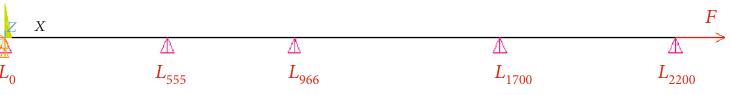
Figure 5: The fi nite element model in Workbench.